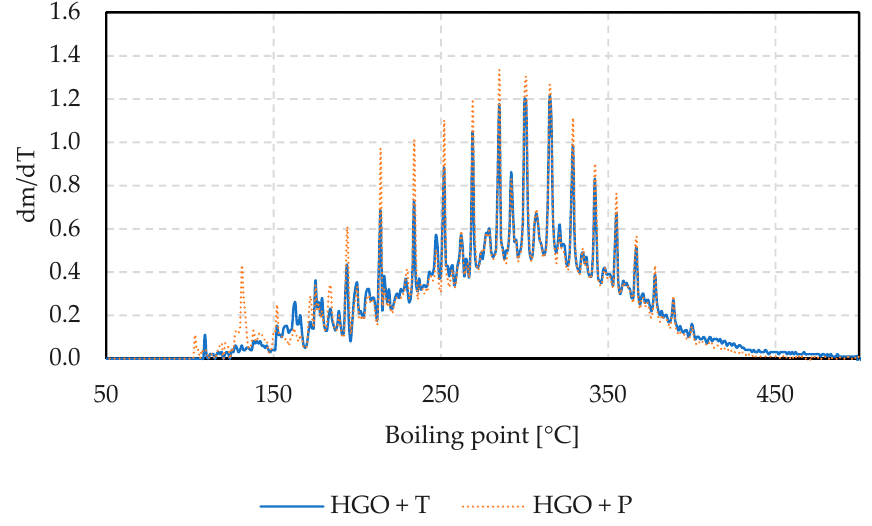
Figure 5. Comparison of the distillation curves of the products, according to the yields. From the samples obtained from hydrotreating, the representative samples were selected, and the average values were obtained for the given reaction condition. These samples were subjected to a detailed characterisation (Table